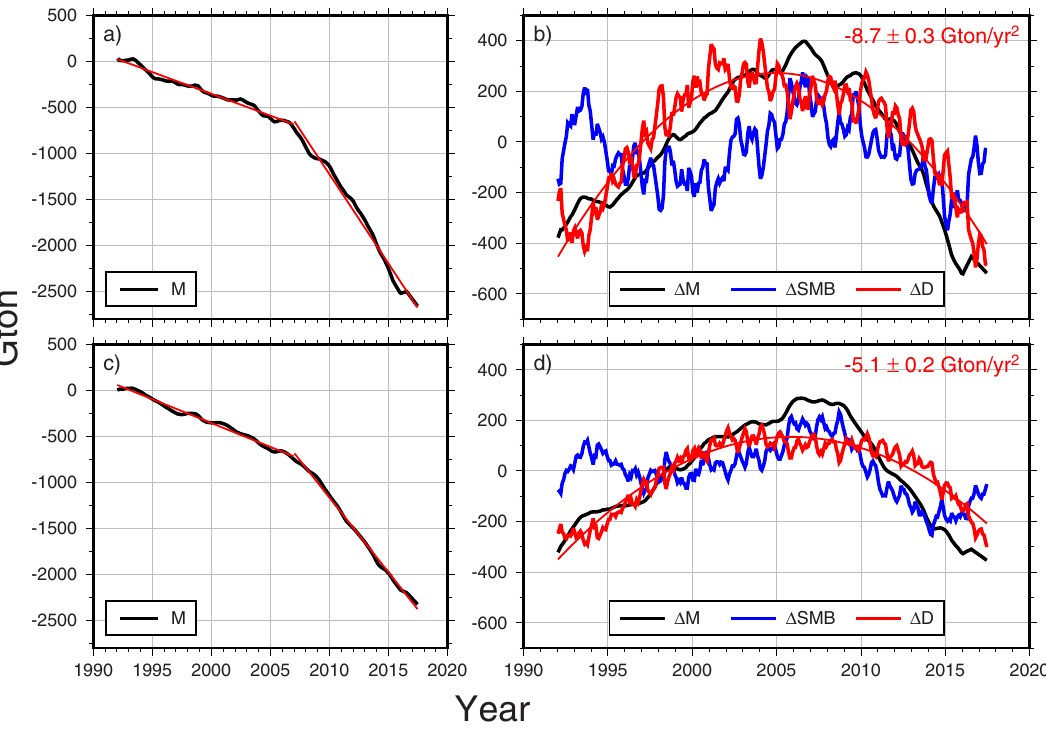
Figure 6. ( a ) AIS ice mass change from IMBIE2 estimates (black). Red lines represent linear trend fits before and after 2007. ( b ) Detrended variability of ice mass (cid:31) M (black), (cid:31) SMB (blue) and (cid:31) D (red). The red number indicates the acceleration rate estimated from the second order polynomial ( a 0 + a 1 t + ( c , d ) are similar to ( a , b ) except for West Antarctica. Figures are created with Generic Mapping Tools (GMT- 5.4.5, https ://gmt.soest .hawai